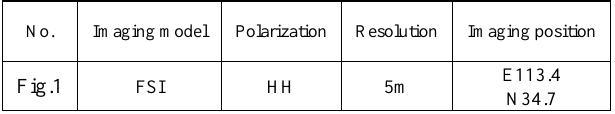
Table 1. The parameters of GF-3 SAR image